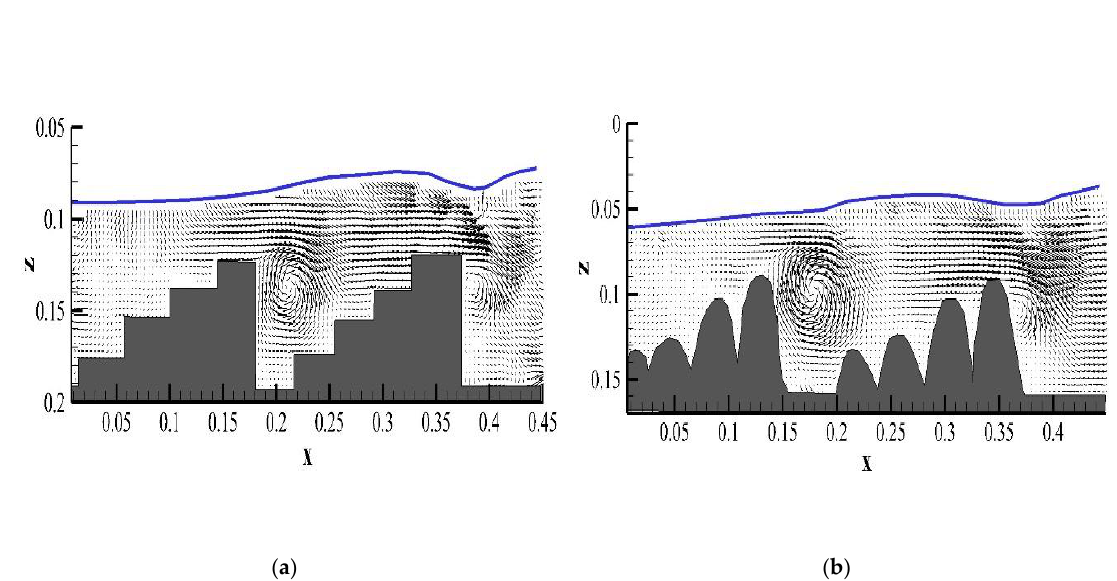
Figure 12. The vortex and velocity distribution around a composite set of submerged breakwaters with a separate distance of w / h = 0.4: ( a ) rectangular submerged breakwater; ( b ) undulating submerged breakwater.